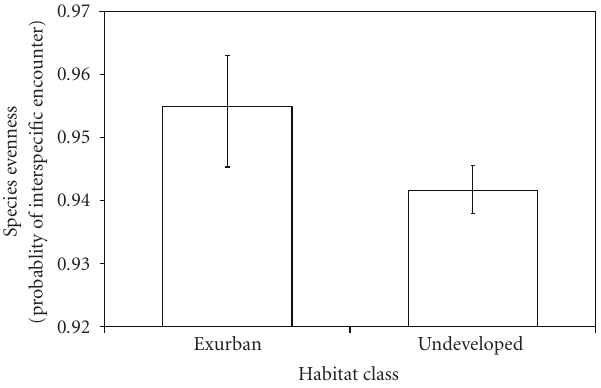
Figure 4: Mean and 95% confidence intervals of bird species evenness in each habitat class. Evenness is shown by the probability of interspecific encounter (PIE; calculated in EcoSim using 95 individuals in each habitat class; [43]). PIE controls for both sampling e ff ort and bird density, and it uses repeated resampling of the data to calculate the probability that the next bird sampled will be of a di ff erent species. Therefore, high PIE values indicate high species evenness.